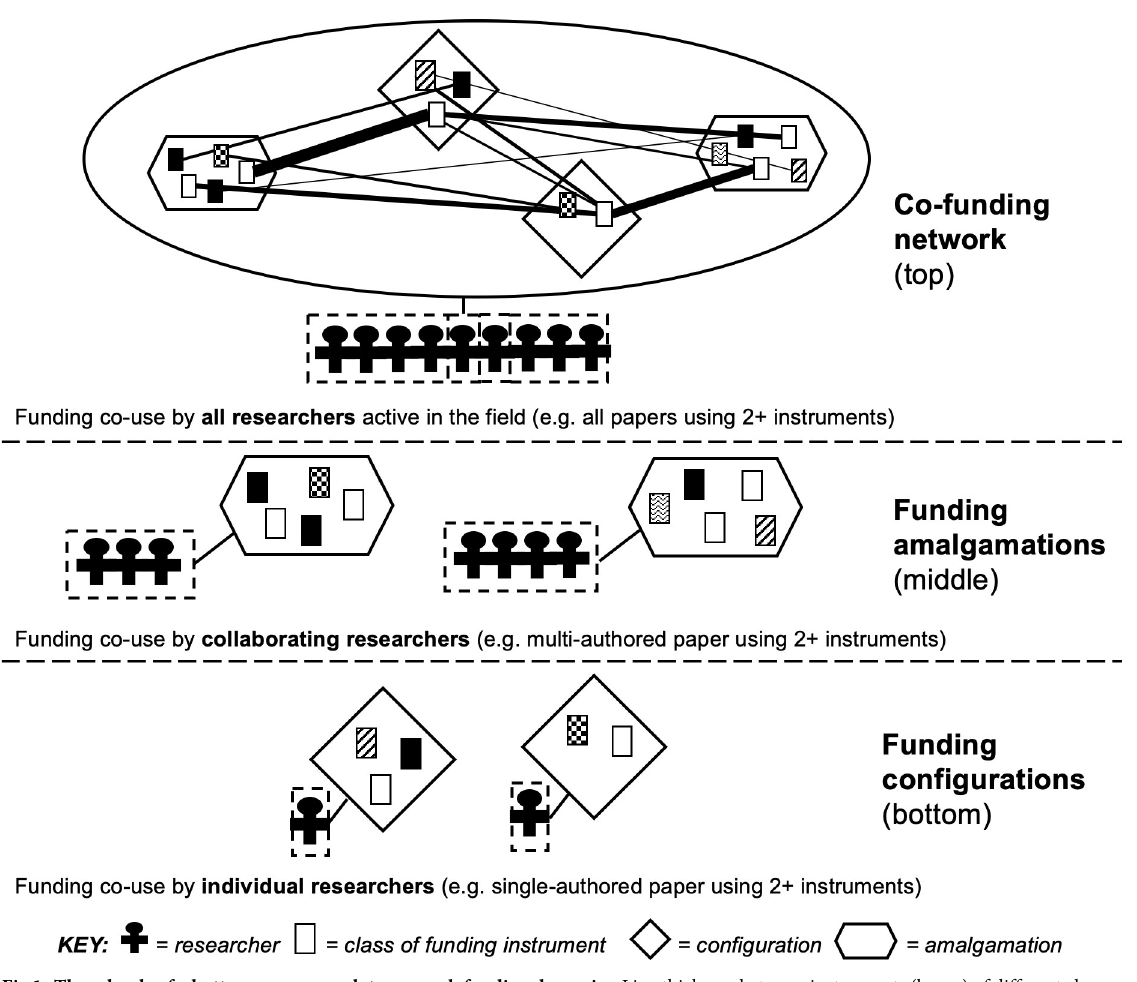
Fig 1. Three levels of a bottom-up approach to research funding dynamics. Line thickness between instruments (boxes) of different classes (e.g. type, origin, providing funder) in the co-funding network represents occurrences of instrument classes that have been